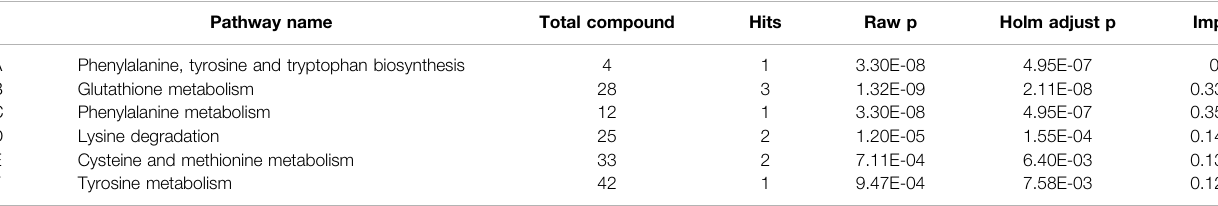
TABLE 3 | Summary of pathways with Metaboanalyst (CON vs. CUMS).